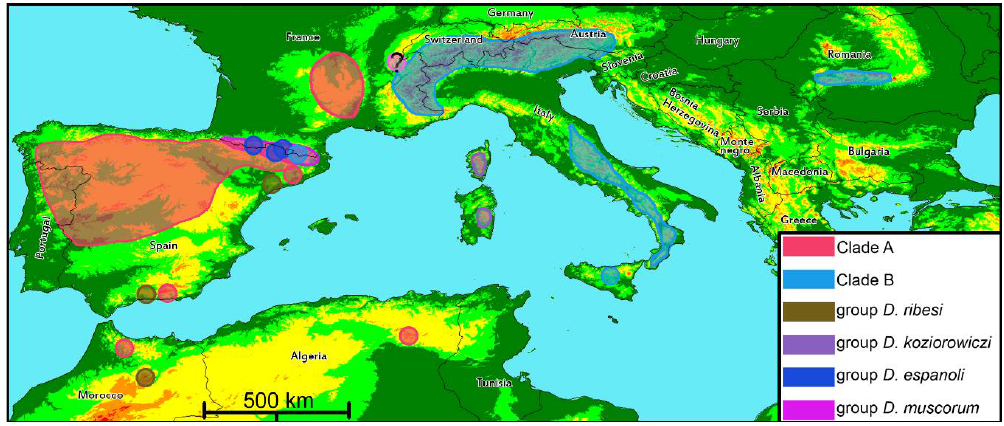
Figure 9. Distribution of the clades and species group of Dichotrachelus . Country level data downloaded from DIVA-GIS Free Spatial Data (http://www.diva-gis.org/Data) and processed with DIVA-GIS.